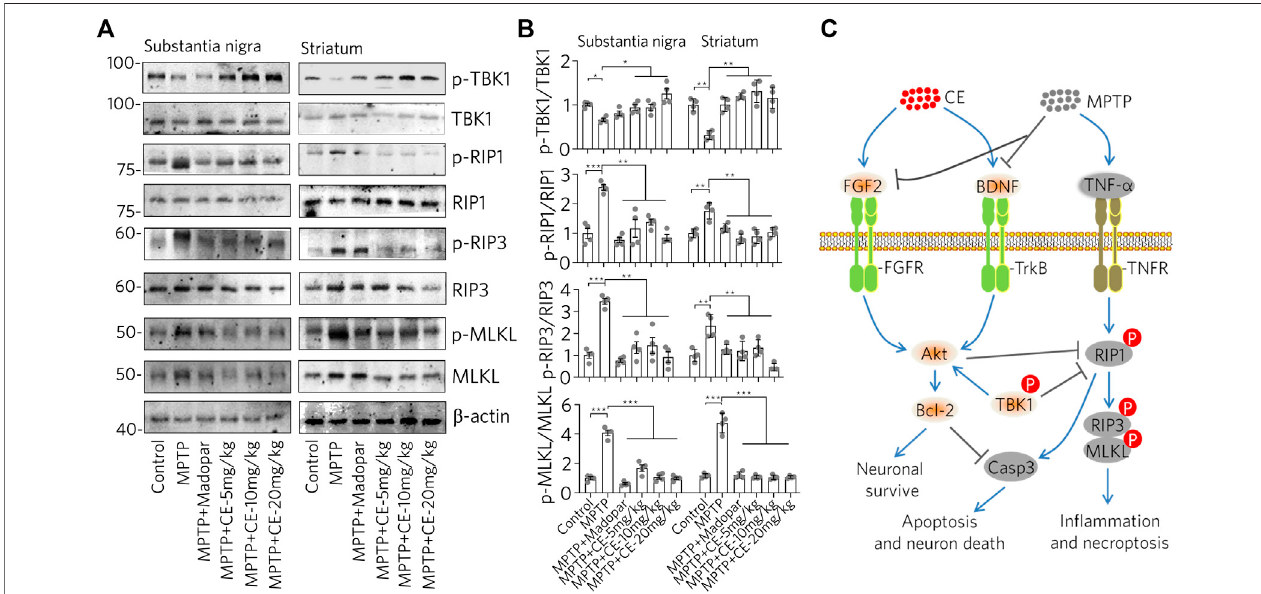
FIGURE6| CEinhibitstheRIP1-drivenin fl ammatorypathwaytriggeredbyMPTP-inducedneurotoxicity. (A) WesternblotofRIP1-drivenin fl ammatorypathwaysin substantianigraandstriatum. (B) Statisticalanalysisofproteinlevelsbasedontheblotsin (A) andnormalizedto β -actin.One-wayANOVAwihtcDunnett ’ stest, n =4. (C) Schematic representation of the anti-PD effects mediated by CE in a mouse model of MPTP-induced PD. In the brain, MPTP impaired the levels of BDNF, FGF2 and its regulated signaling pathways, as well as the RIP1-driven in fl ammatory pathway, leading to apoptosis of dopaminergic neurons. However, CE attenuated MPTP- induced toxicity and abnormalities in the above-mentioned signaling pathways to protect